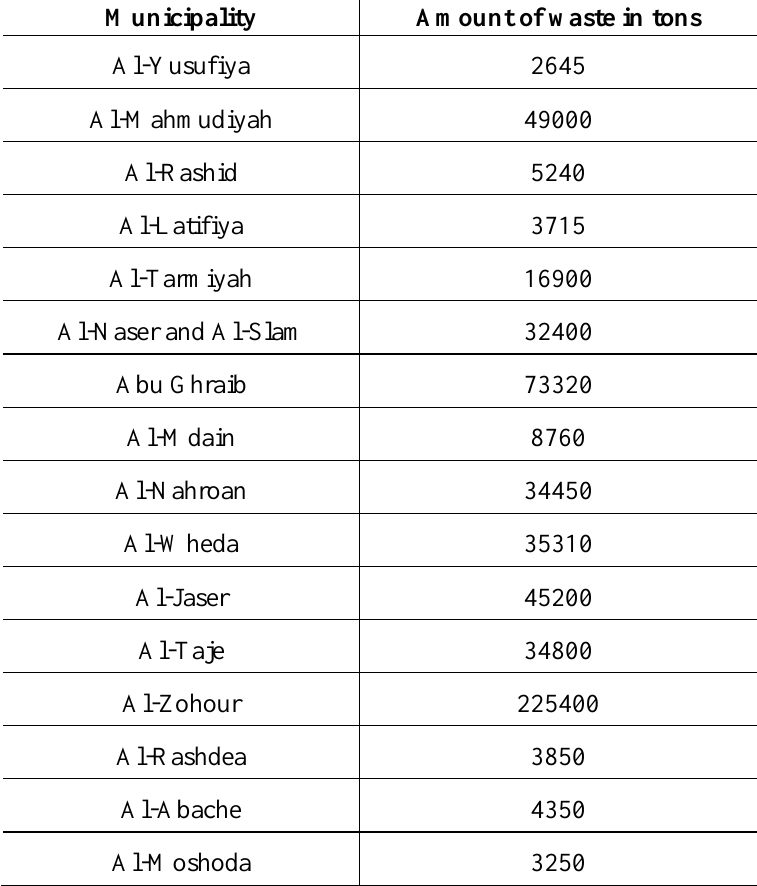
Table 2: The amount of waste produced in the outskirts of Baghdad governorate, according to 2016\2020